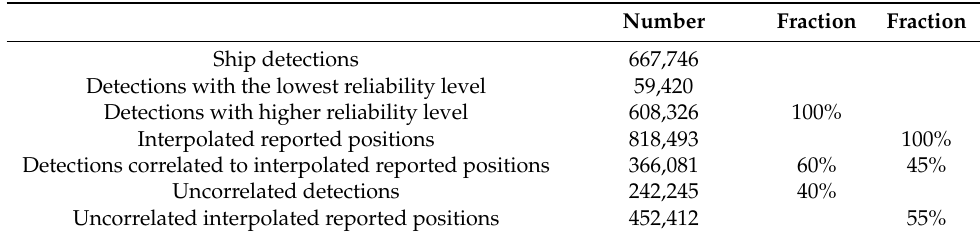
Table 2. Summary of ship detection and correlation results (excluding off Israel